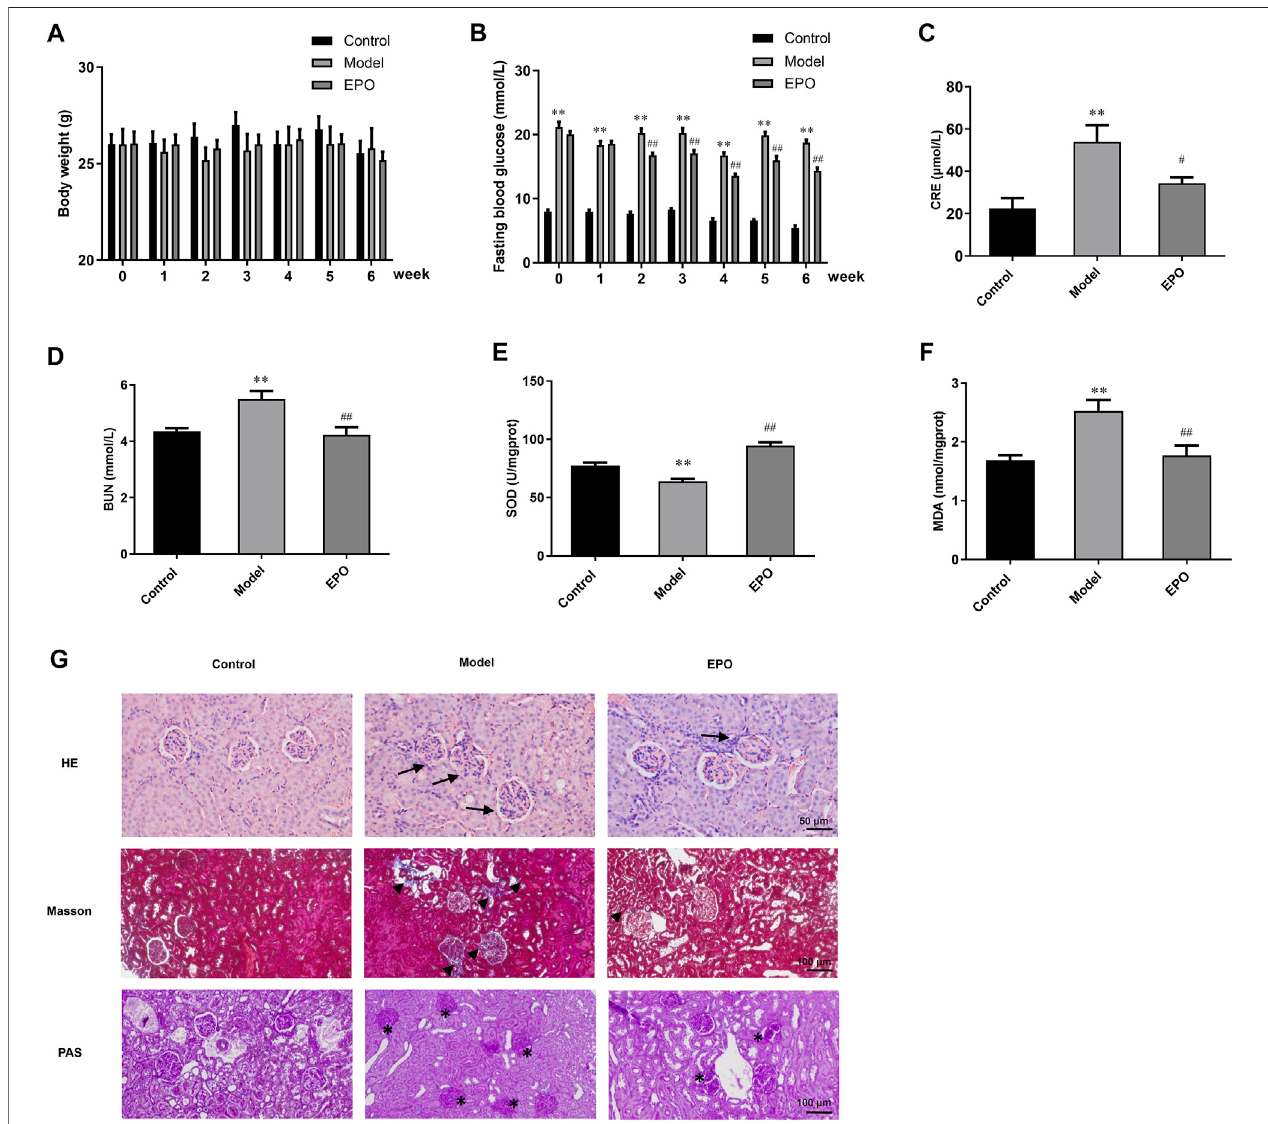
FIGURE5| EPOprotectedrenalfunctionsandmorphologicalcharacteristicsofDNmice. (A) Thechangesofbodyweight, (B) FBGlevels, (C) serumcreatinine, (D) blood urea nitrogen, (E) SOD activity, MDA, and (G) histological staining of kidney tissues in terms of HE, Masson and PAS staining. Arrows indicate the abnormal glomerular structure, arrowheads indicated the fi brosis deposition and asterisks indicate the deposition of mesangial matrix. Values are presented as mean ± SEM, for (A,B) , n = 8; for (C,D) , n = 3; for (E,F) , n = 5. ** p < 0.01 vs. Control group; # p < 0.05, ## p < 0.01 vs. Model group.